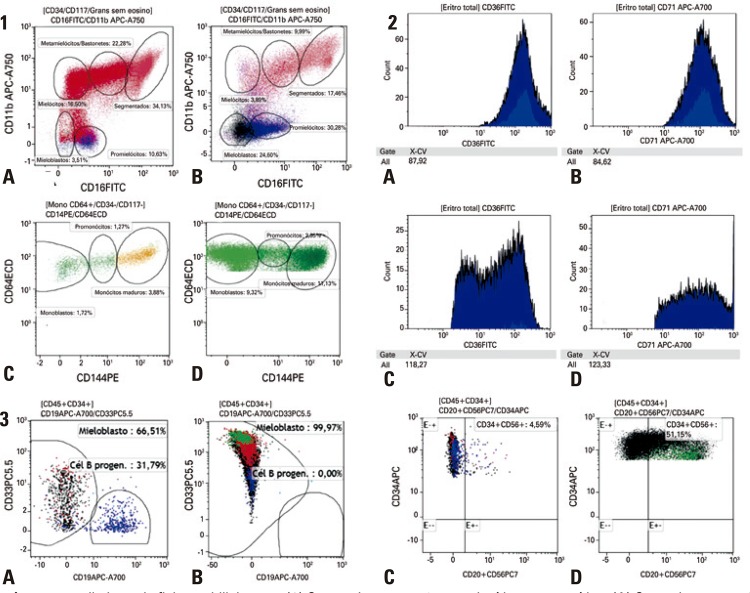
Exemplos de parâmetros avaliados pela ficha multilinhagem. (1) Curvas de maturação granulocítica e monocítica. (A) Curva de maturação normal CD11b/CD16. (B) Curva de maturação com aumento de precursores mieloides e diminuição das formas mais maduras. (C) Curva de maturação monocítica normal. (D) Curva de maturação com aumento de monoblastos e promonócito. (2) Avaliação da série eritróide. (A) Padrão de normalidade para o coeficiente de variação do CD36. (B) Padrão de normalidade para o coeficiente de variação do CD71. (C) Coeficiente de variação do CD36 acima dos valores de normalidade. (D) Coeficiente de variação do CD71 acima dos valores de normalidade. (3) Parâmetros de avaliação das células progenitoras. (A) Distribuição normal das células progenitoras entre mieloblastos e células progenitoras B. (B) Aumento de mieloblastos e diminuição de células progenitoras B. (C) Normalidade com negatividade de expressão do CD56 nas células CD34. (D) Expressão anômala de CD56 em células CD34+